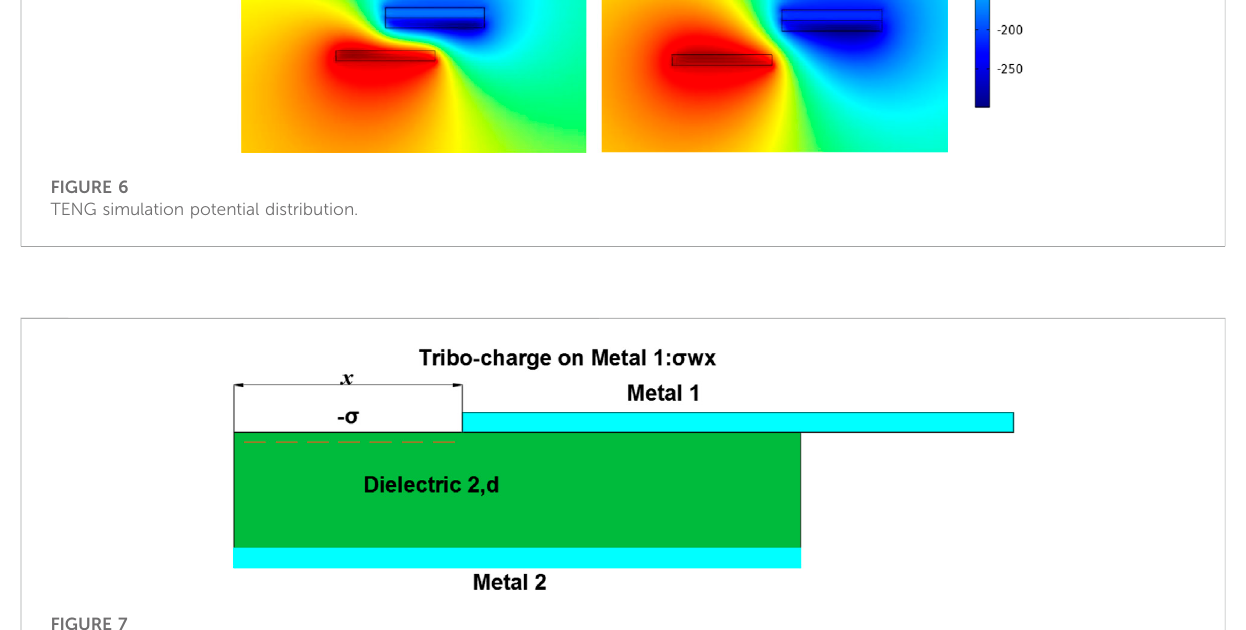
FIGURE 7 TENG Theoretical